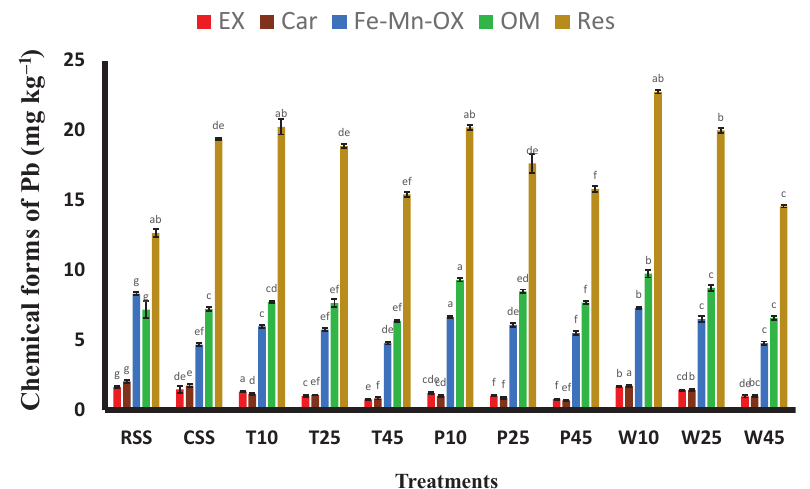
Figure 5: Chemical forms of Pb in RSS and produced compost samples. Different letters (in the same chemical forms of treatments) indicate significant differences among the mean of different treatments (p < 0.05). Error bars represent the standard deviation. (Each abbreviation in x-axis is defined in Table